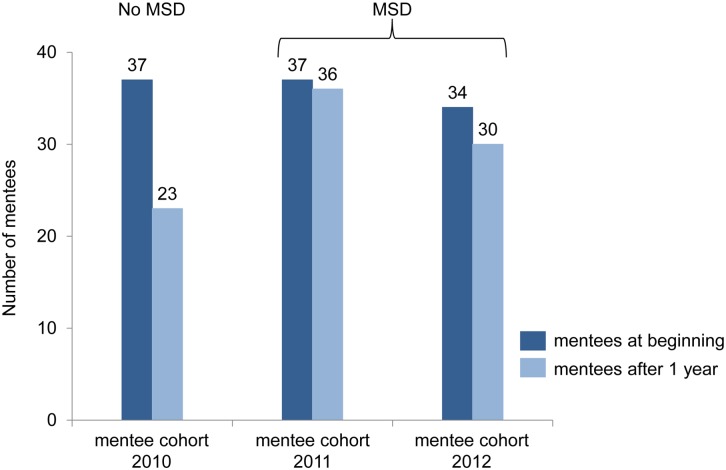
Frequencies of mentees’ dropout after 1 year mentorship.Cohort 2010 constituted the “no mentoring speed dating (no MSD)” group and the cohorts 2011 and 2012 constituted the “mentoring speed dating (MSD)” group.